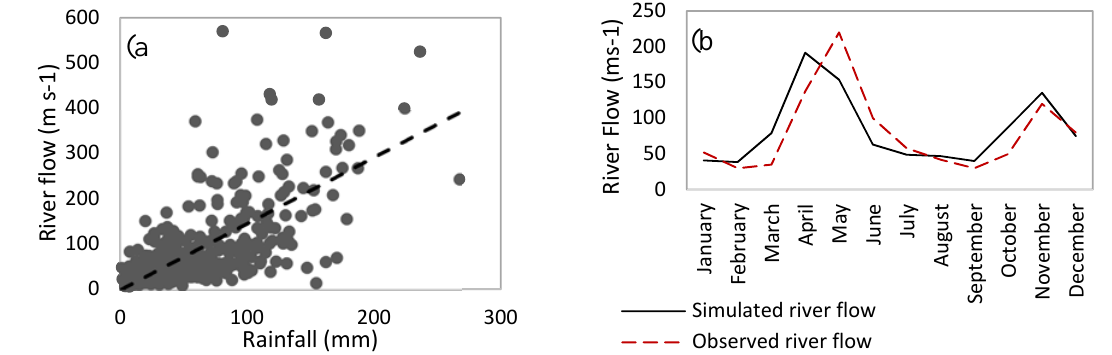
Figure 2. ( a ) Correlation between rainfall and inflow per month; ( b ) Average simulated river flow and historic river flow averages for historic data based on rainfall.